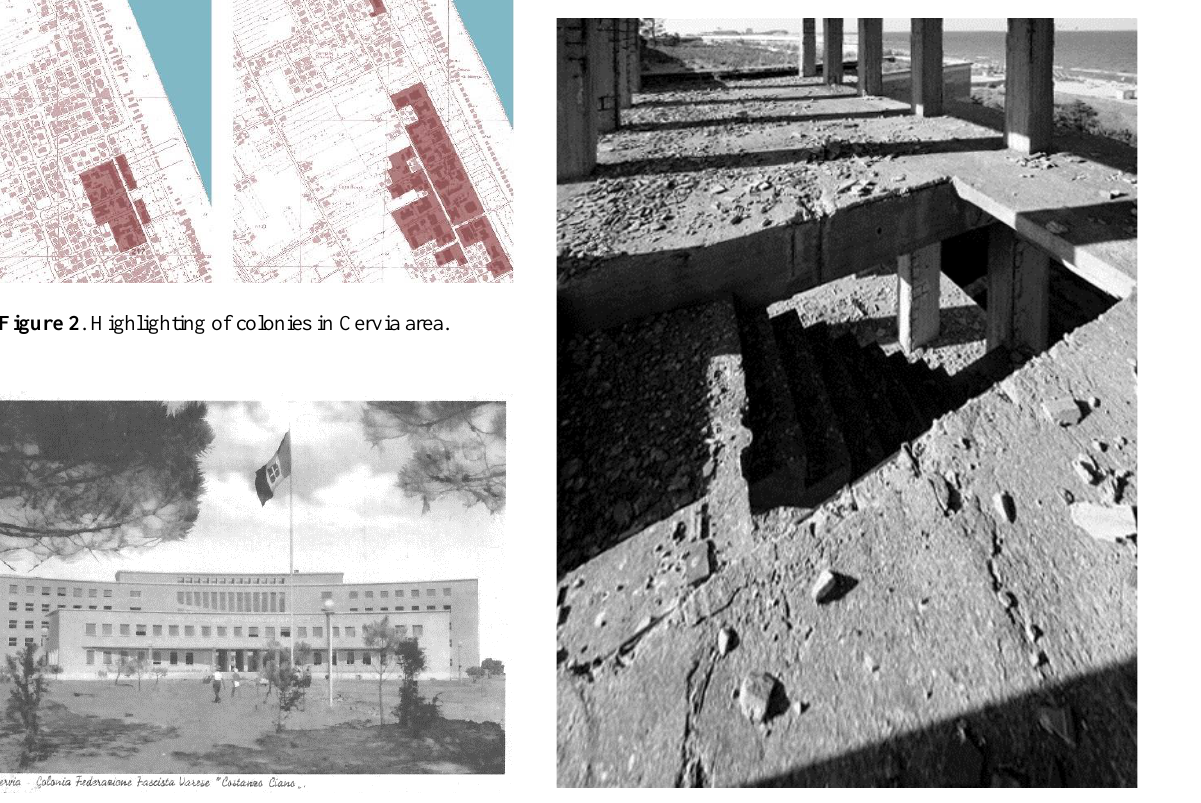
Figure 5. Varese Colony in